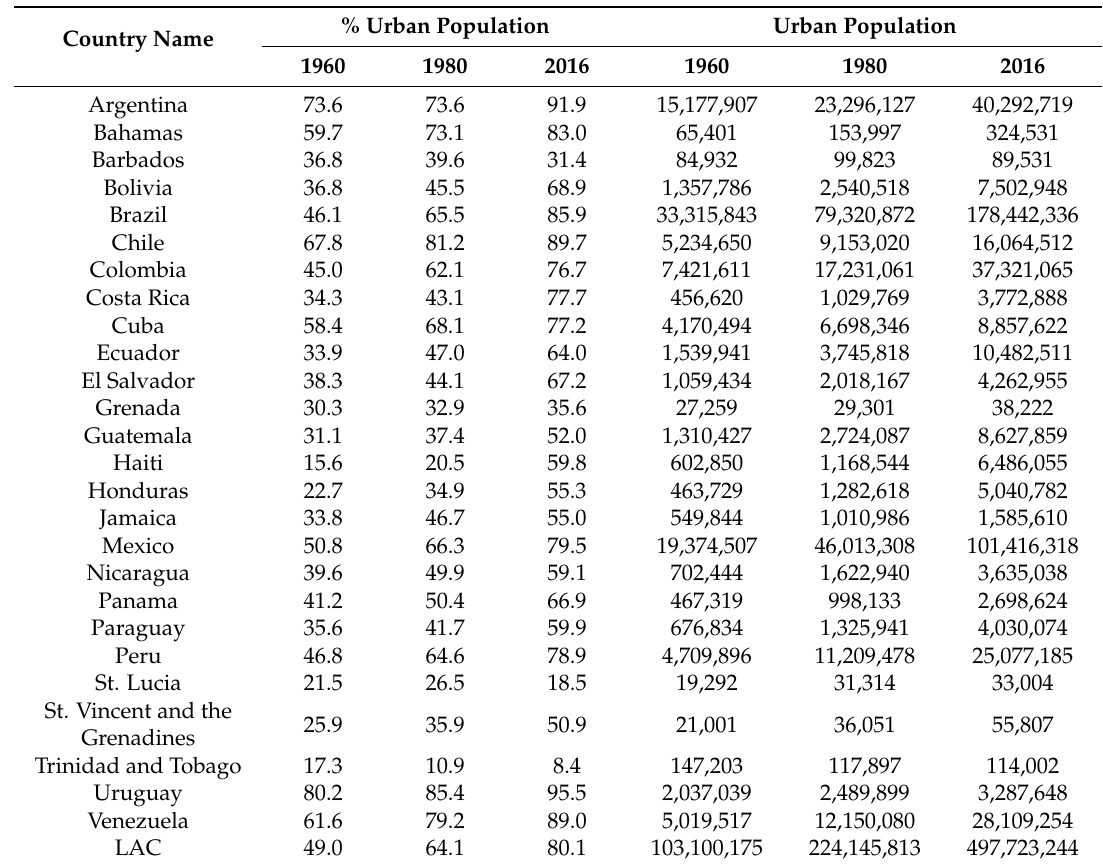
Table 2. Urbanization Statistics for the LAC countries